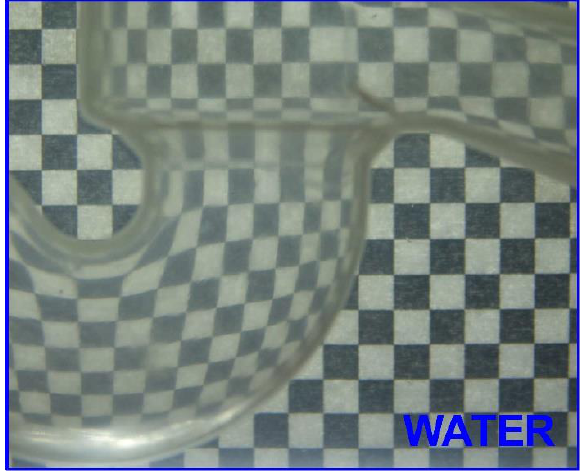
Fig. 2. Visual inspection of the optical deformation in the measured area using water (1.33 Ri) as the working fluid.